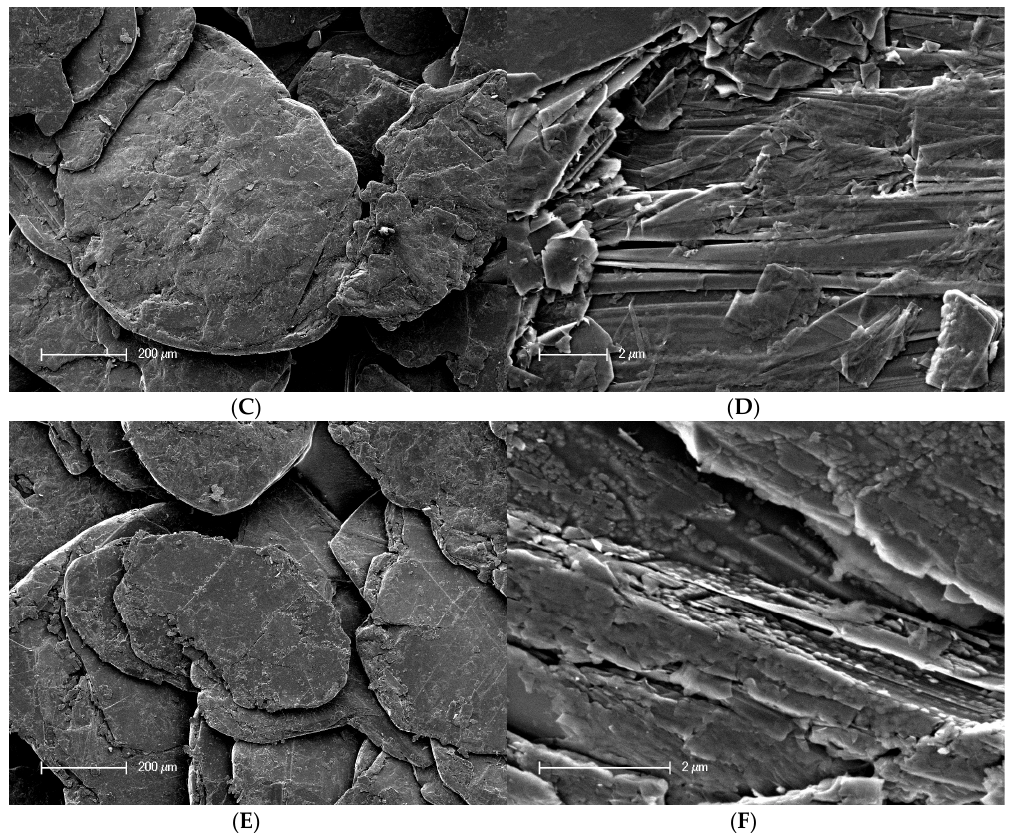
Figure 5. Scanning electron micrographs taken of the untreated reference fiber sample ( A,B ) and differently oxy-fluorinated carbon fiber samples: 5 vol% fluorine ( C,D ) and 10 vol% fluorine ( E,F ).